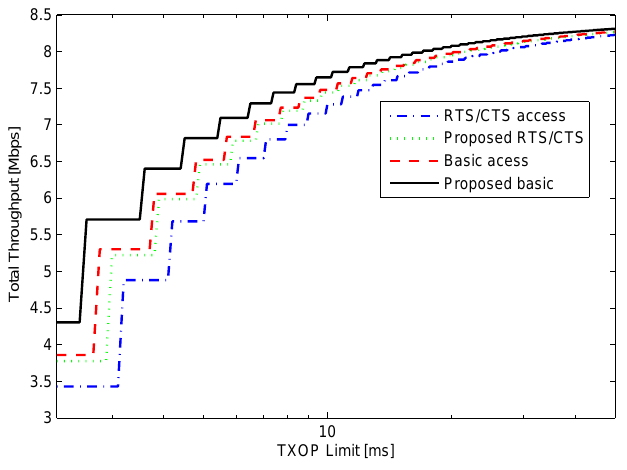
Figure 4. Throughput for n = 10, r = 1 Mbps, r = 11 Mbps, and bit error probability (BER) =